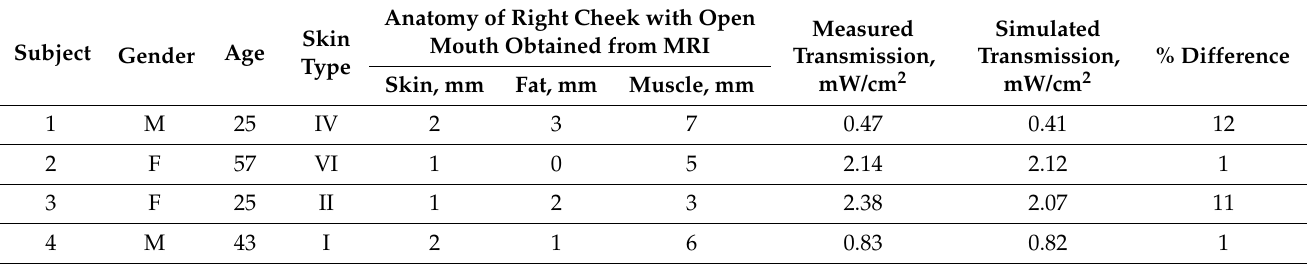
Figure 3. Axial T1-weighted MR images through the face acquired from subjects 1 ( A ), 2 ( B ), 3 ( C ), and 4 ( D ). The red line on each image depicts the trajectory along which a representative light beam travels during transmission measurements. Measurements were made along this red line from the surface of the skin to the surface of the buccal mucosa. Table 2. Summary of validation data.